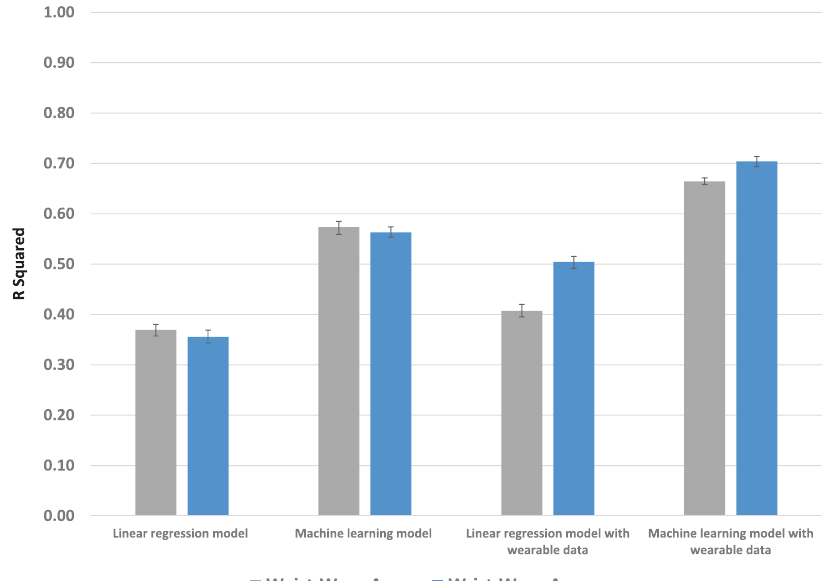
Fig. 2 Prediction of continuous change in hemoglobin A1c. Displayed by type of model (linear regression or ensemble machine learning), use of data (with or without wearable data), and location of wearable (waist or wrist). Data presented are R squared and 95% con fi dence intervals from the testing set.